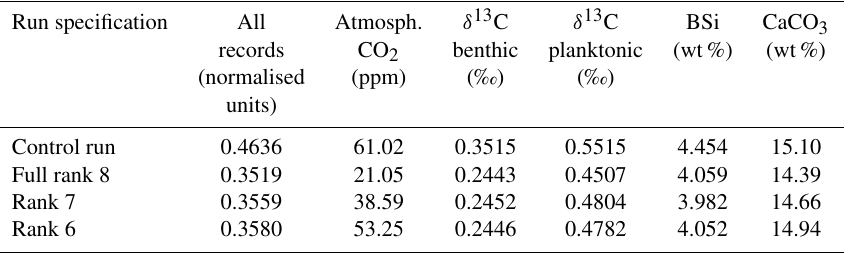
Table 6. Average goodness of fit expressed as root mean square error for the control run base line and the different optimisations. The values for the optimisations are estimated from the linear fitting procedure.